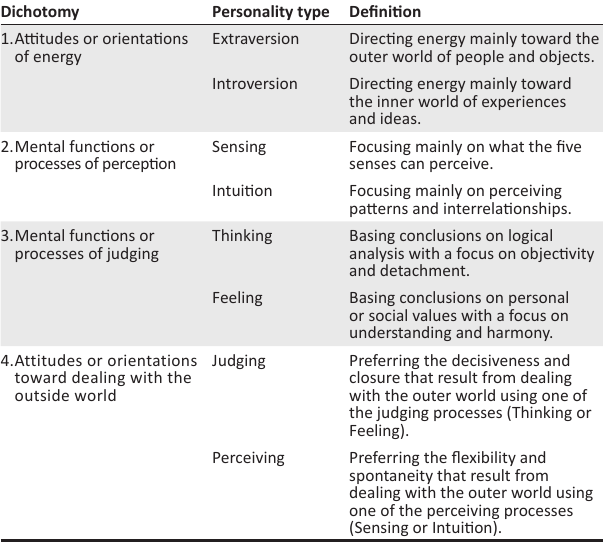
TABLE 1 : The four dichotomies of Personality Type